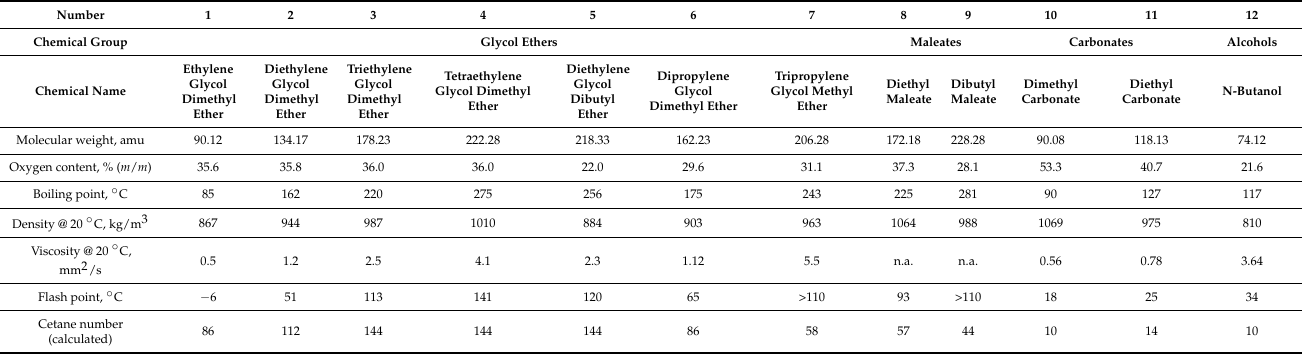
Table 1. Several properties of the oxygenates used in the tests.